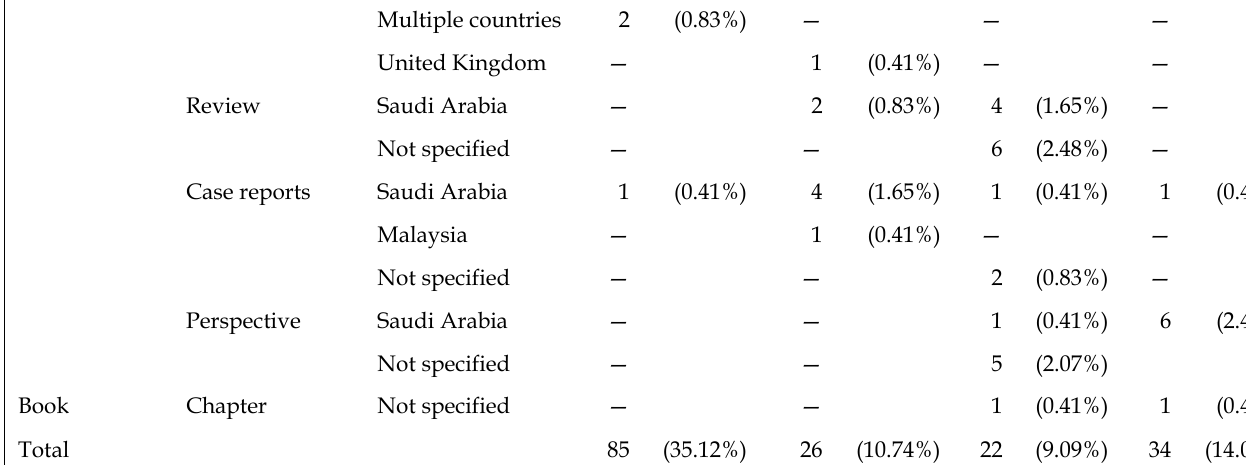
Table 1 A descriptive summary of health informatics (HI) publications by Saudi-affiliated authors